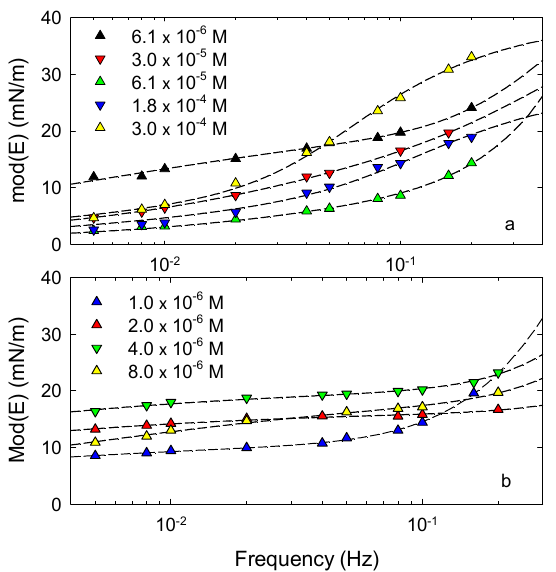
Figure 7. Modulus of the dilational viscoelasticity measured by the Oscillating Drop method for saponin ( a ) and for Tween 80 ( b ). Dashed curves obtained fitting a theoretical expression of mod(E) like in Reference [25] from the model presented in Reference [41].